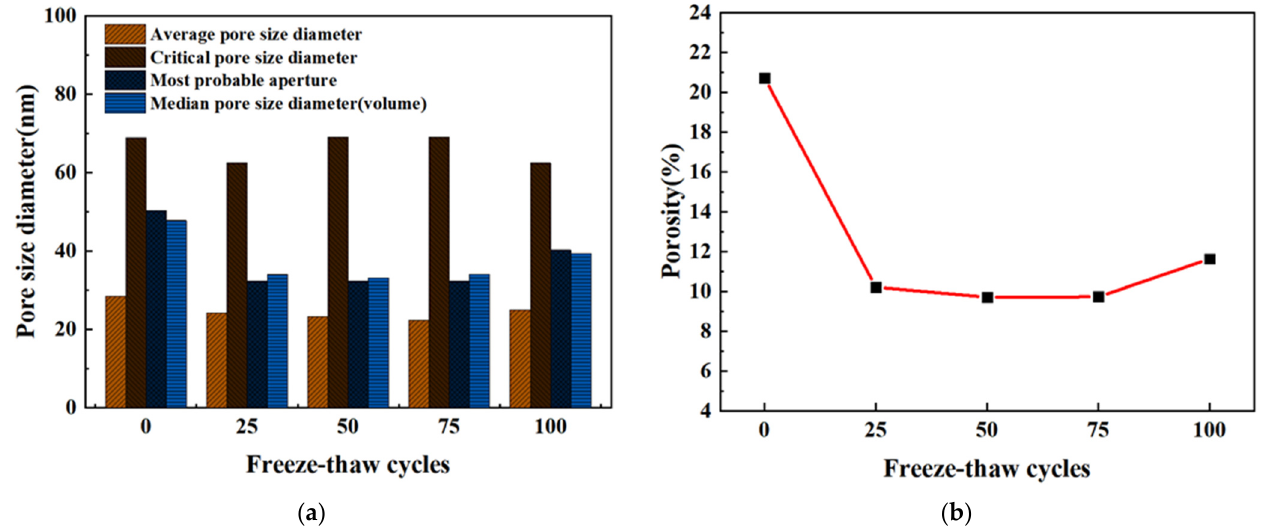
Figure 12. Variation of pore structure characteristic parameters of cement paste with different freeze-thaw cycles. ( a ) Changes of pore size parameter; ( b ) Changes of porosity change.